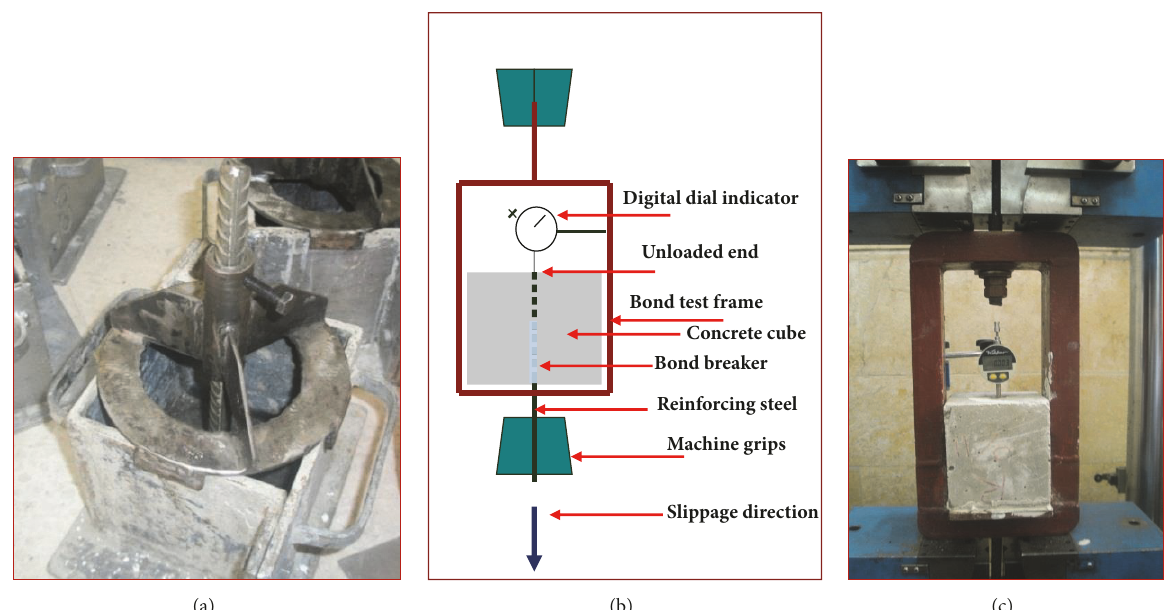
Figure 4: (a) Photograph of the mold used in the bond test with the bar in place; (b) sketch map of the bond set up; (c) photograph of the bond test setup with the specimen in